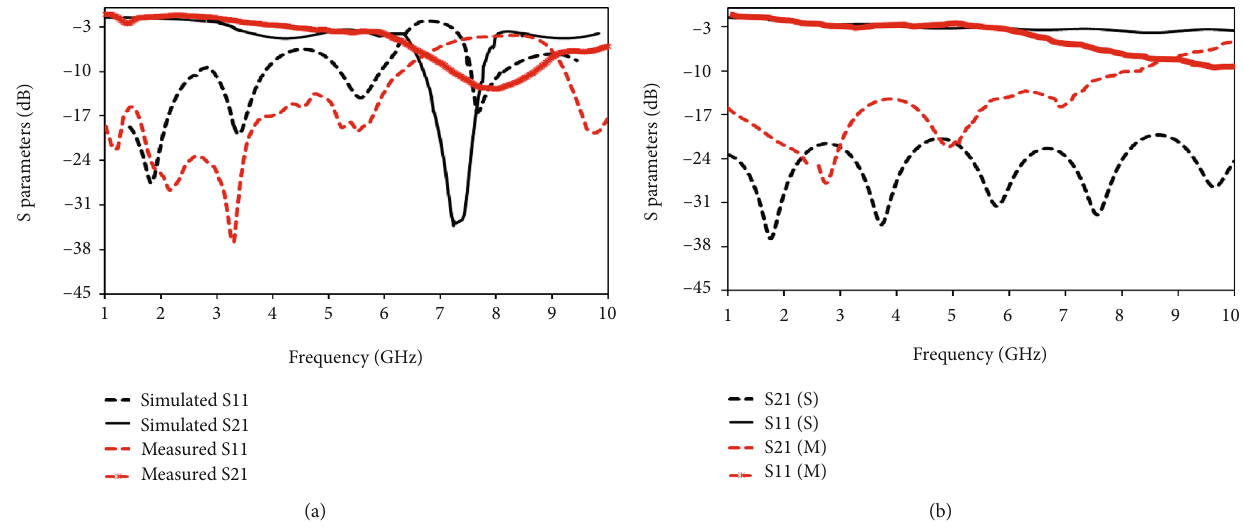
Figure 10: S parameter vs. frequency of PIN diode in (a) ON state and (b) OFF state.